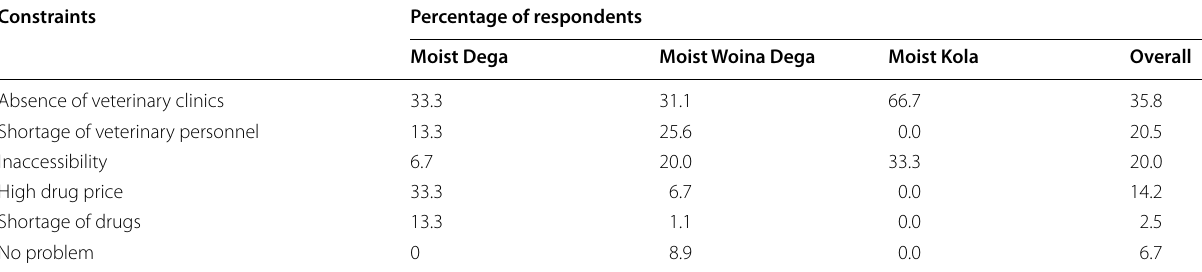
Table 5 Constraints in animal health delivery in Dale Pilot Learning Woredas, Southern Ethiopia. Source : Endeshaw (2007) Constraints Percentage of respondents Moist Dega